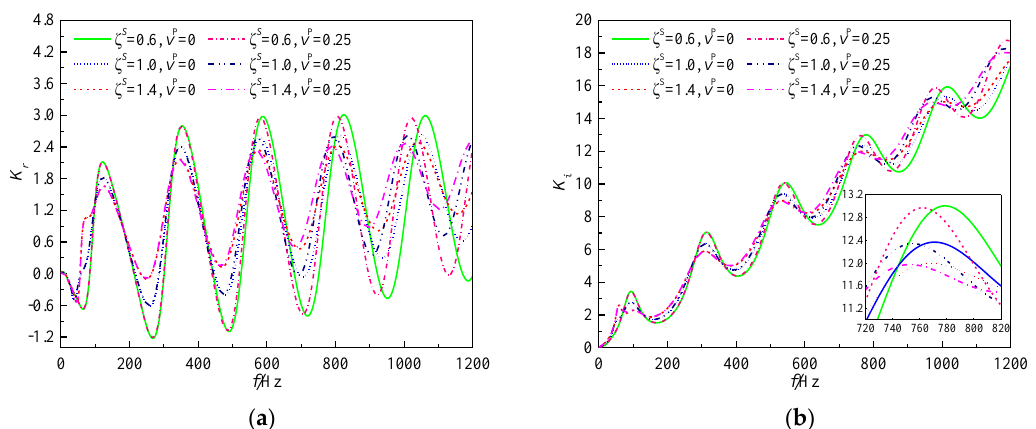
Figure 5. Variation of dynamic impedance with the coe ffi cient of the disturbance degree: ( a ) true sti ff ness and ( b ) equivalent